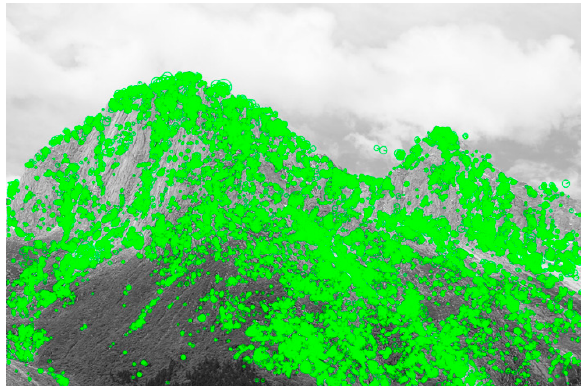
Figure 2. The feature extraction using the AKAZE algorithm.